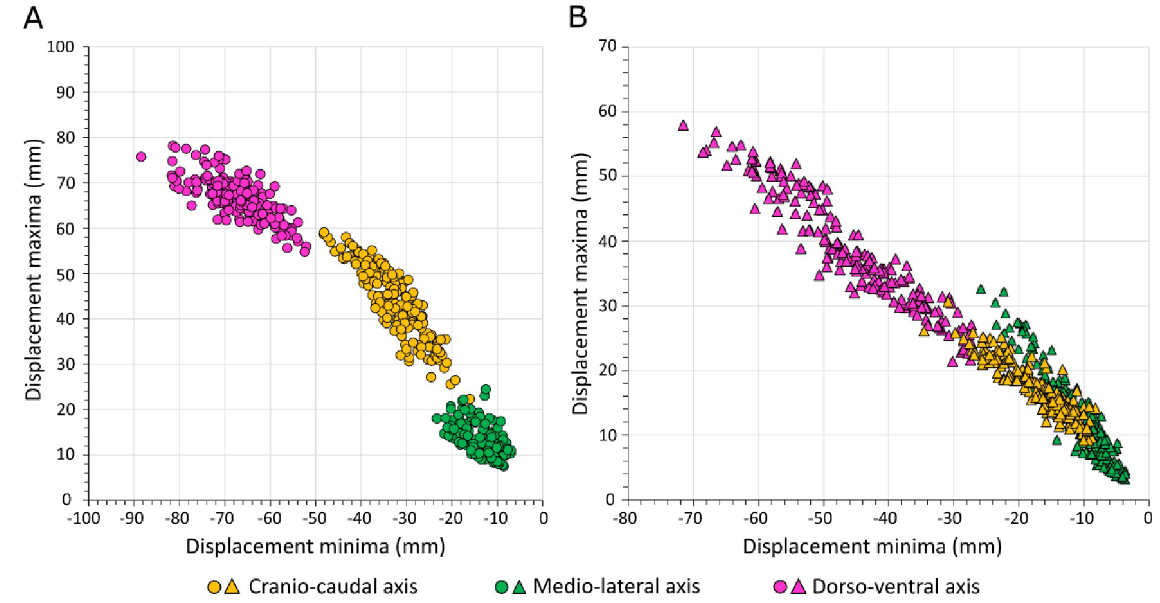
Fig 5. Positive relationship between the magnitude of displacement minima and maxima for individual trials. A . Horse data. B . Jockey data.